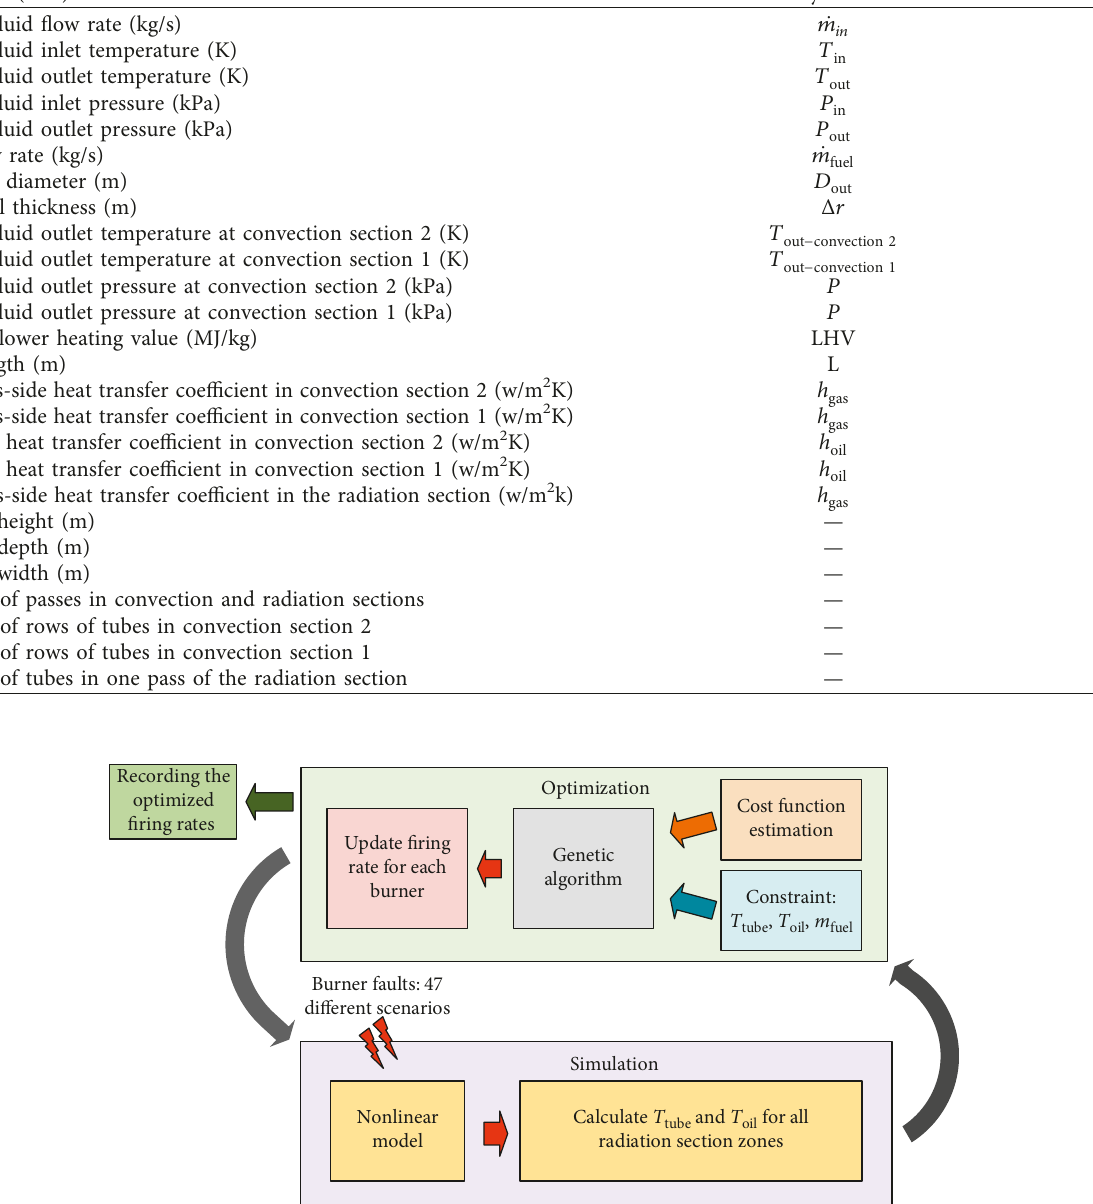
Figure 2: Procedure of the optimization problem for obtaining the appropriate firing